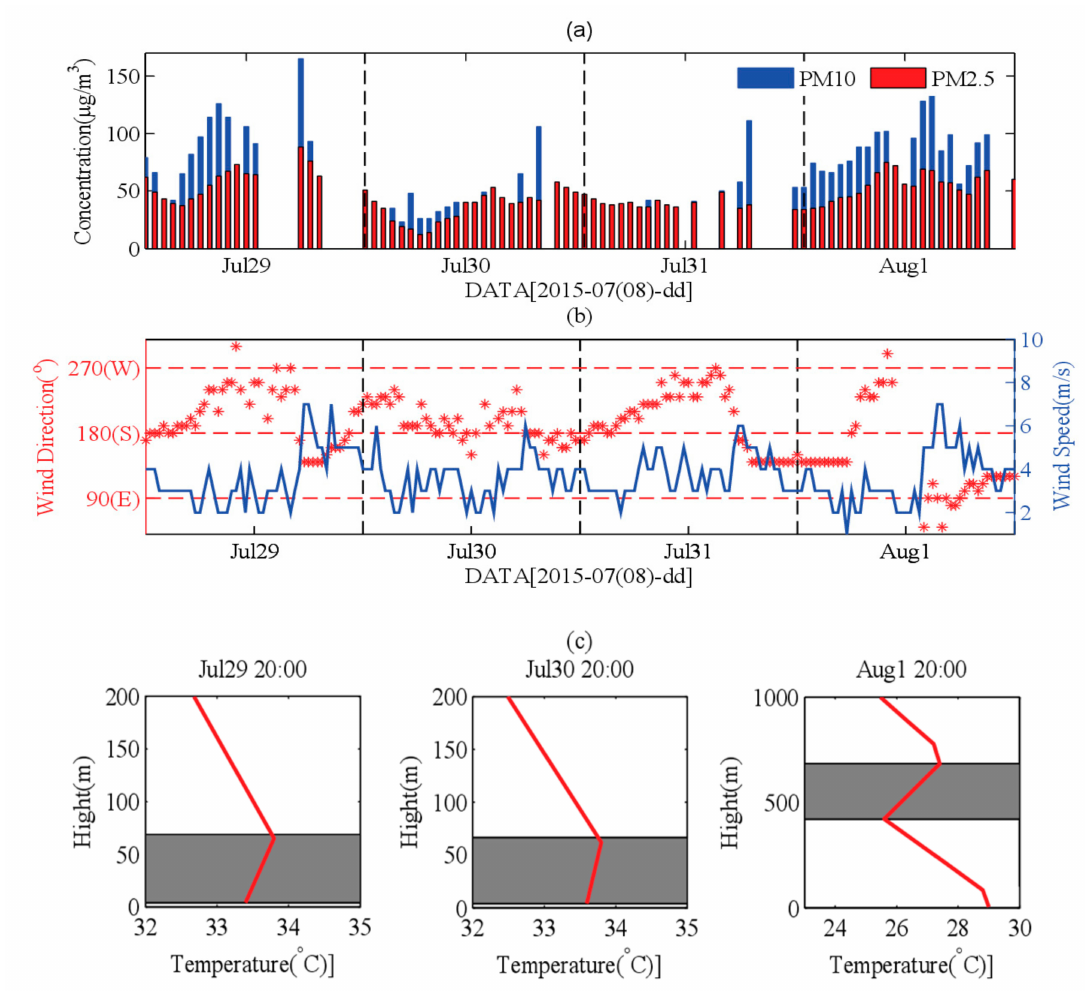
Figure 12. Diurnal variation of ( a ) PM10 and PM2.5, ( b ) wind direction and wind speed in Shanghai from 28 July to 5 August 2015, and ( c ) Inversion layer at 20:00 on 29 July, 30 July, and 1